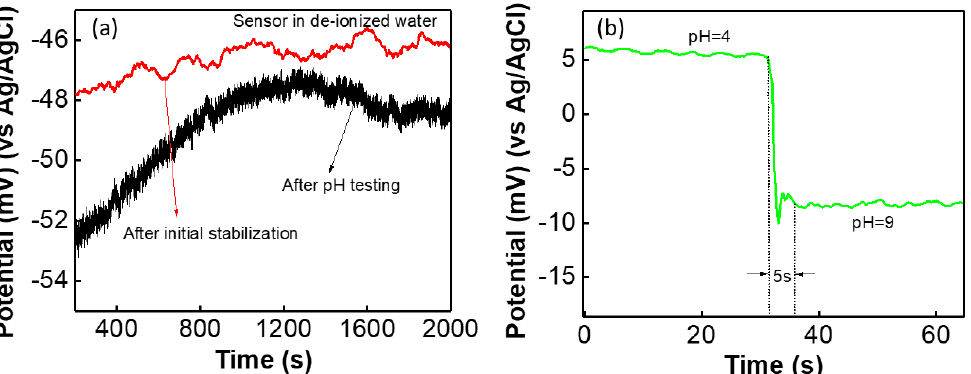
Figure 6. ( a ) Potentiometric cloth-based sensor performance in deionized water after initial stabilization and after measuring in pH solution. ( b ) Response time of the sensor in pH solutions.